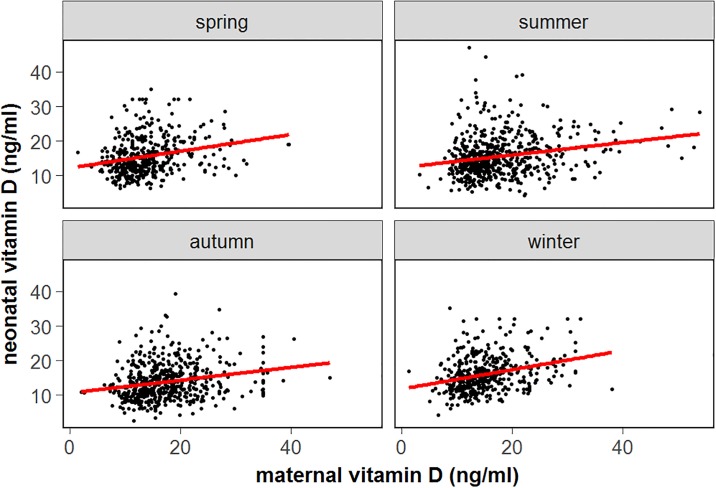
Association between maternal 25(OH)D level during pregnancy and neonatal cord blood 25(OH)D level distributed by maternal blood drew season.